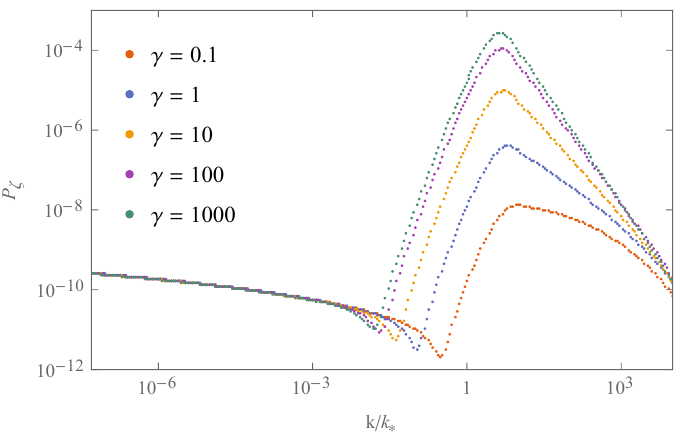
at ∆ N 2 = 10 for some values of γ . 2